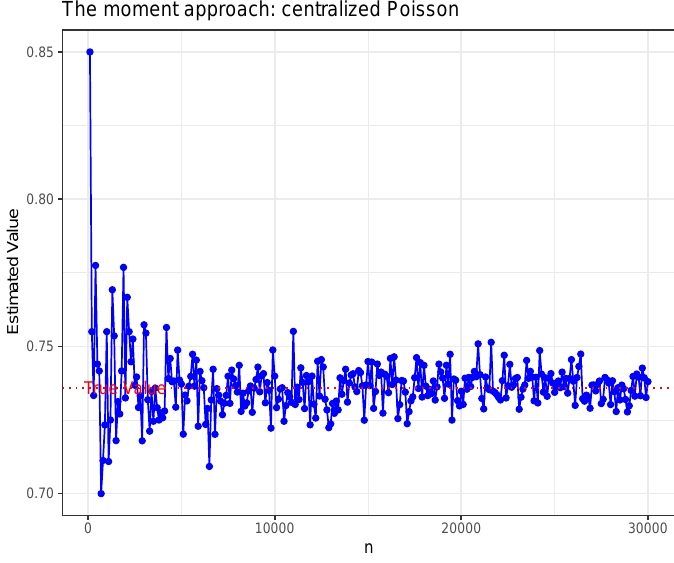
Figure 5. centralized